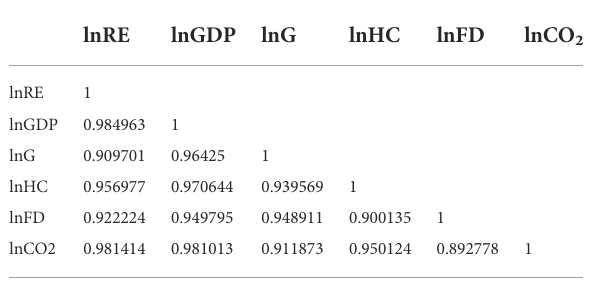
TABLE 3 Correlation